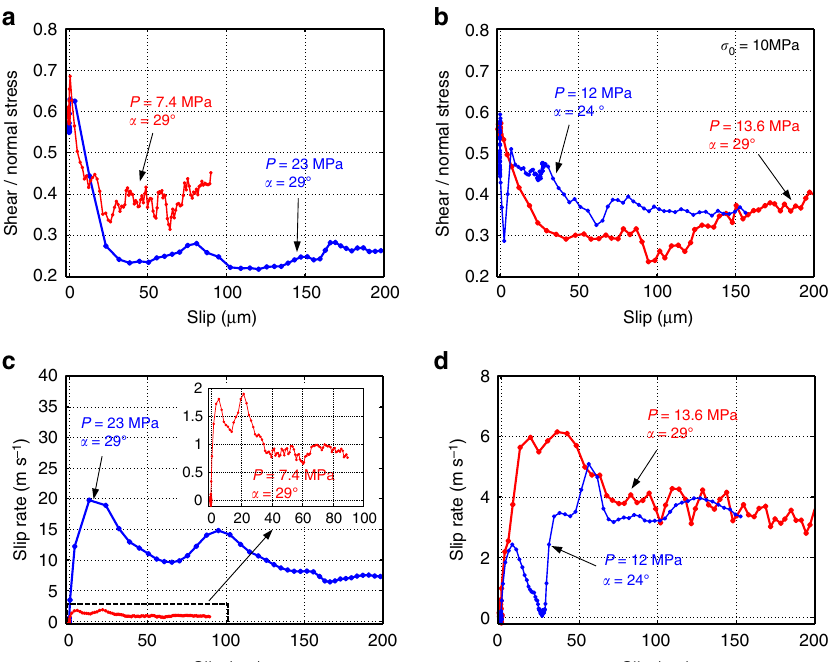
Figure 5 | Rupture evolution with slip. ( a , b ) Evolution of friction ( ¼ shear to normal stress ratio during slip) with slip on the interface at the center of the field of view shown in Fig. 1. The four experimental ruptures have different dependence of friction on slip, indicating that the friction cannot be described by a purely slip-dependent law. ( c , d ) Evolution of slip rate versus slip for the same ruptures. The four ruptures are characterized by significantly different slip-rate histories, which result in different friction at any given value of